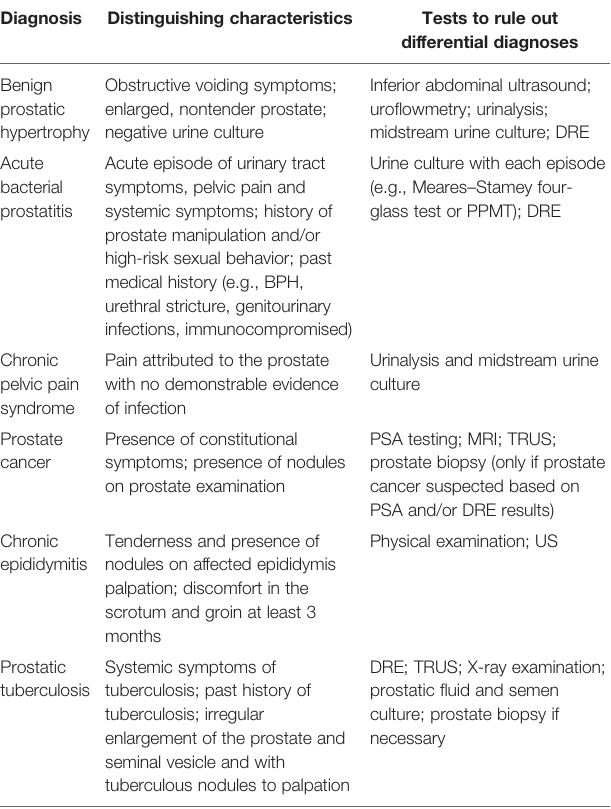
TABLE 2 | Differential Diagnosis of Chronic Bacterial